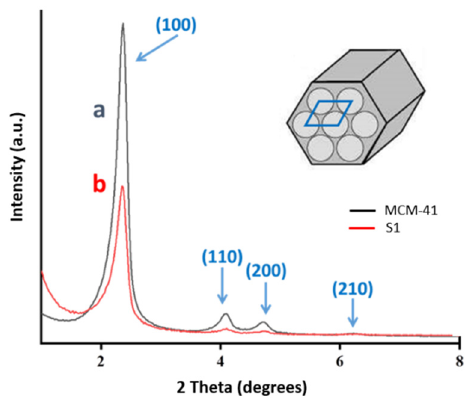
Figure 2. Powder X-ray diffraction (PXRD) patterns of the starting MCM-41 ( a ) and the S1 solid ( b ). A schematic representation of the hexagonal ordered mesoporous array, including the unit cell typical of the MCM-41 silica is presented.